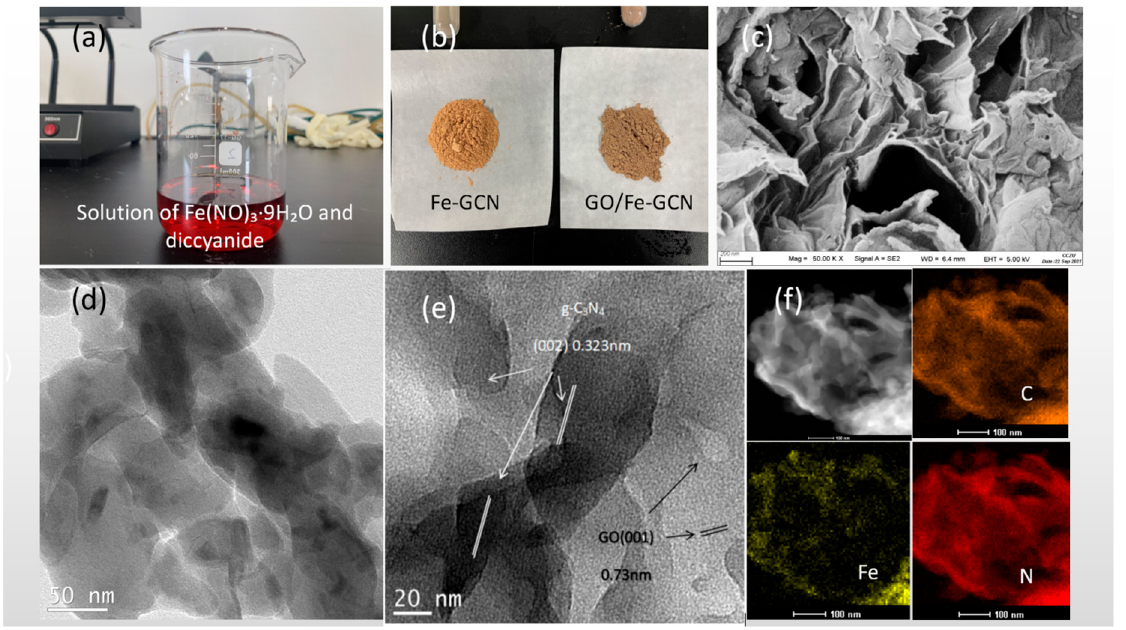
Figure 1. Solution of Fe(NO 3 ) 3 ·9H 2 O and diccyanide ( a ), image of Fe-GCN and GO/Fe-GCN ( b ), SEM image of GO/Fe-GCN ( c ), TEM image of GO/Fe-GCN ( d ), HRTEM of GO/Fe-GCN ( e ), and STEM image with overlapping of Fe, C, and N elements ( f ).